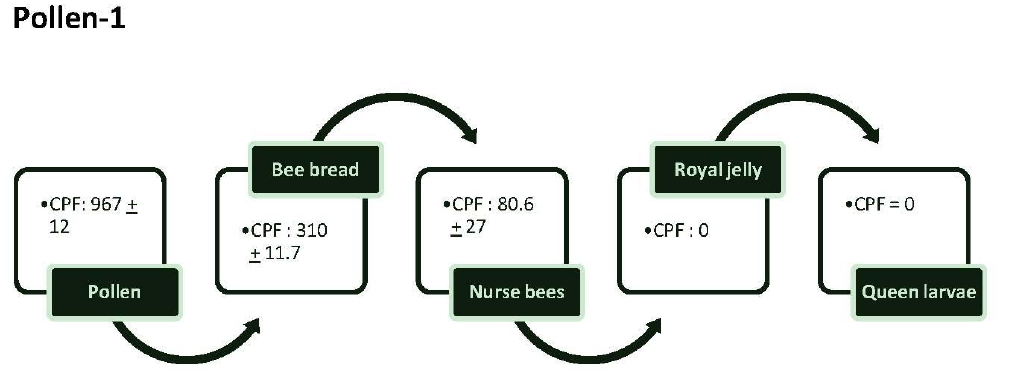
Figure 1. The flow of average amounts (±SEM) of chlorpyrifos (CPF), boscalid (Bos) and Pyraclostrobin (Pyr) from pollen into bee bread, nurse bees feeding on the bee bread, royal jelly secreted by the nurse bees and queen larvae feeding on the royal jelly. Two samples of bee bread from 3 colonies fed pollen-1 and 5 from those fed pollen-2 also were